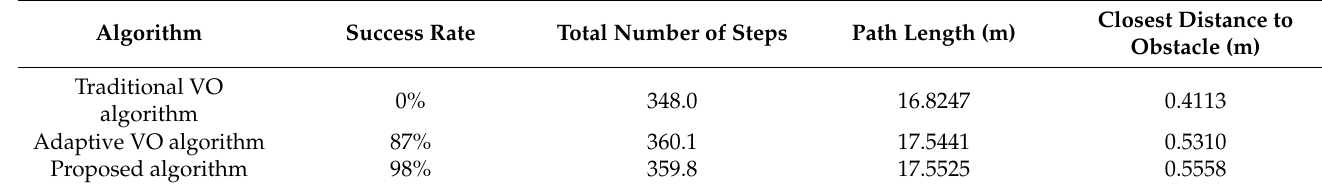
Table 2. Performance comparison considering skid